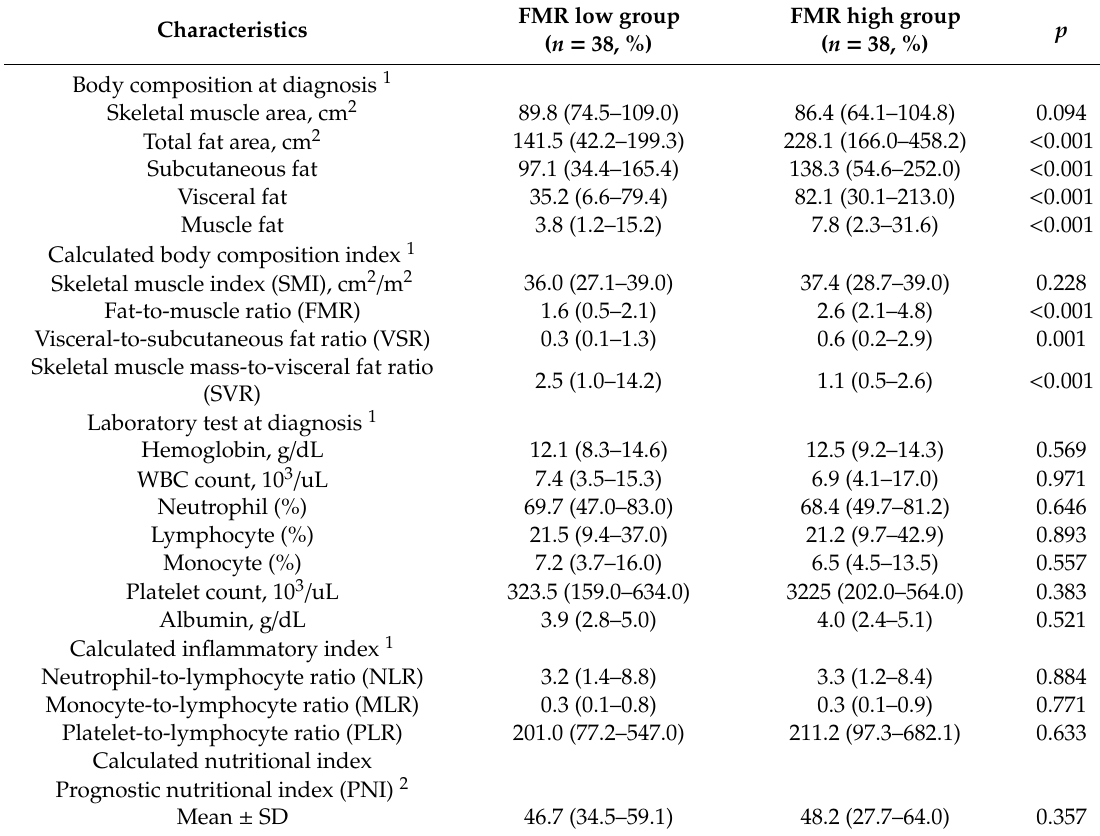
Table 5. Body composition and laboratory results of sarcopenia patients. 1 Median (range). 2